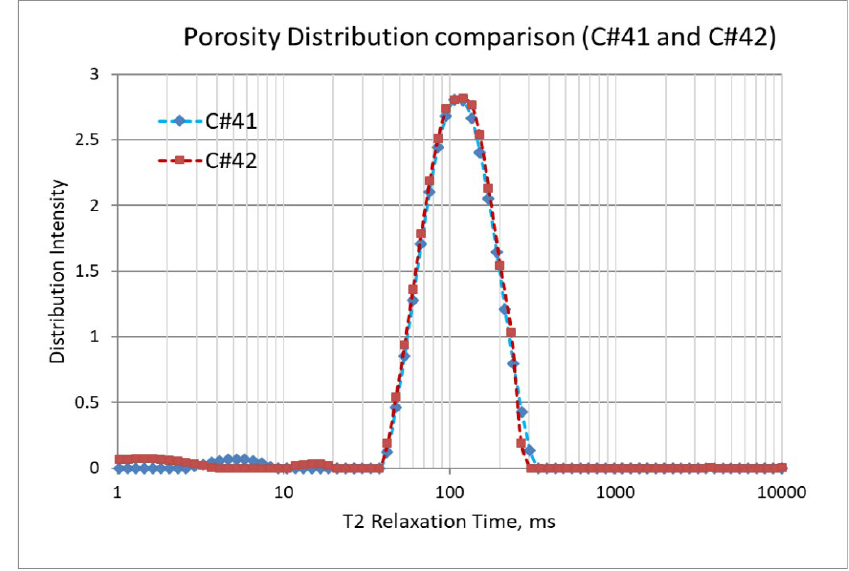
Figure 7. NMR porosity distribution comparison between C#41 and C#42.